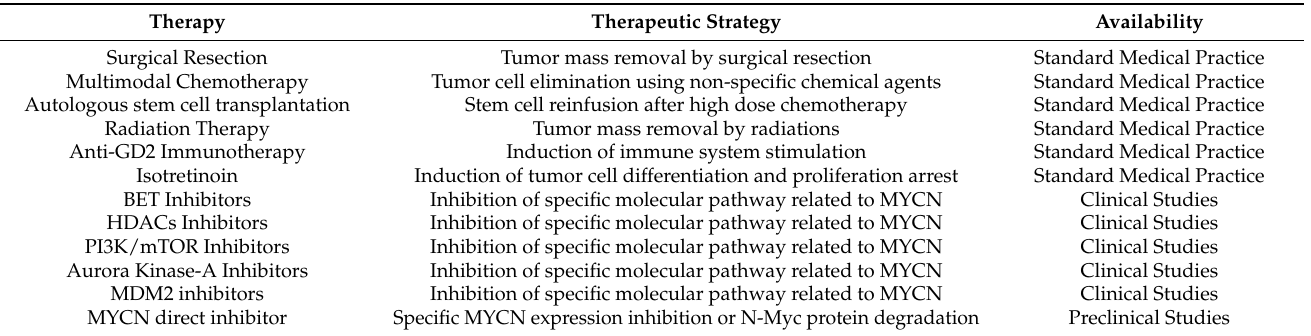
Table 2. Summary of current therapies and the new therapeutic approach in the treatment of neuroblastoma and high-risk neuroblastoma. Therapy Therapeutic Strategy Surgical